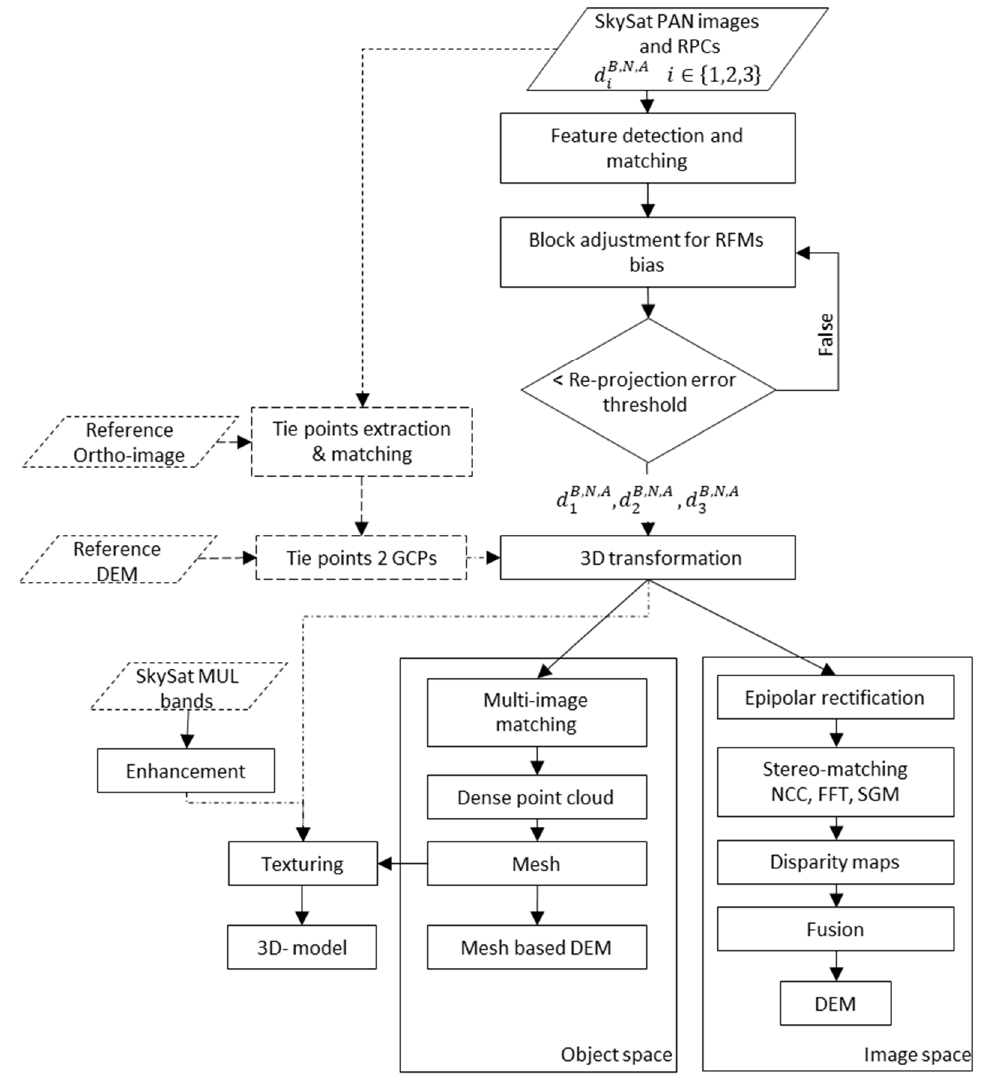
Figure 4. Schematic workflow for SkySat image geometry refinement and 3D extraction.